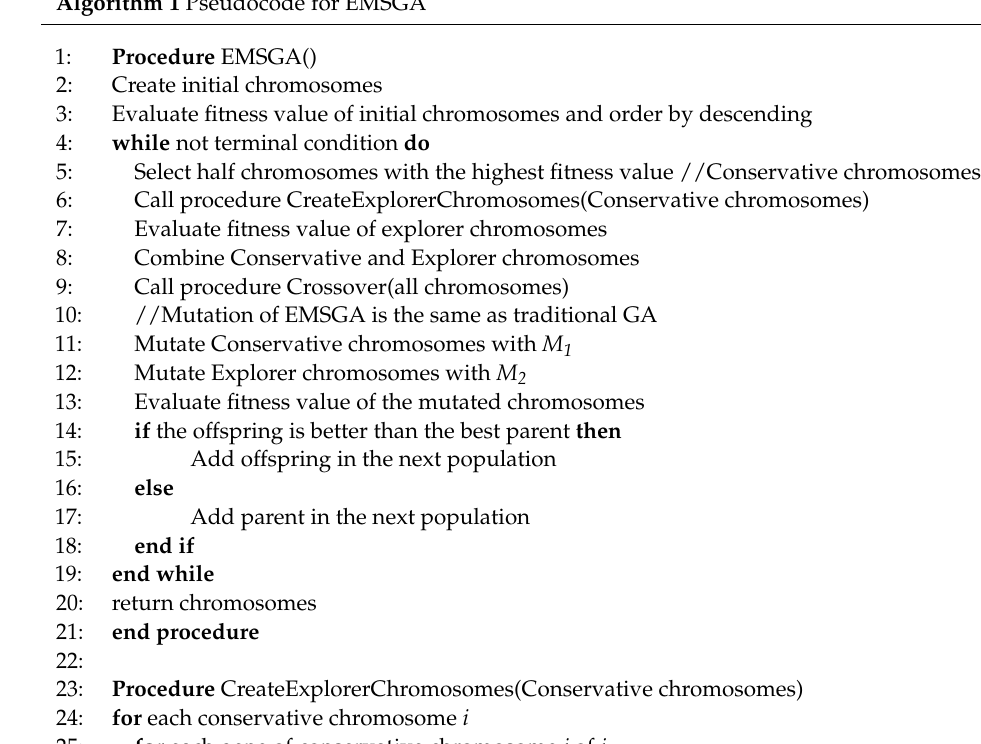
Algorithm 1 Pseudocode for